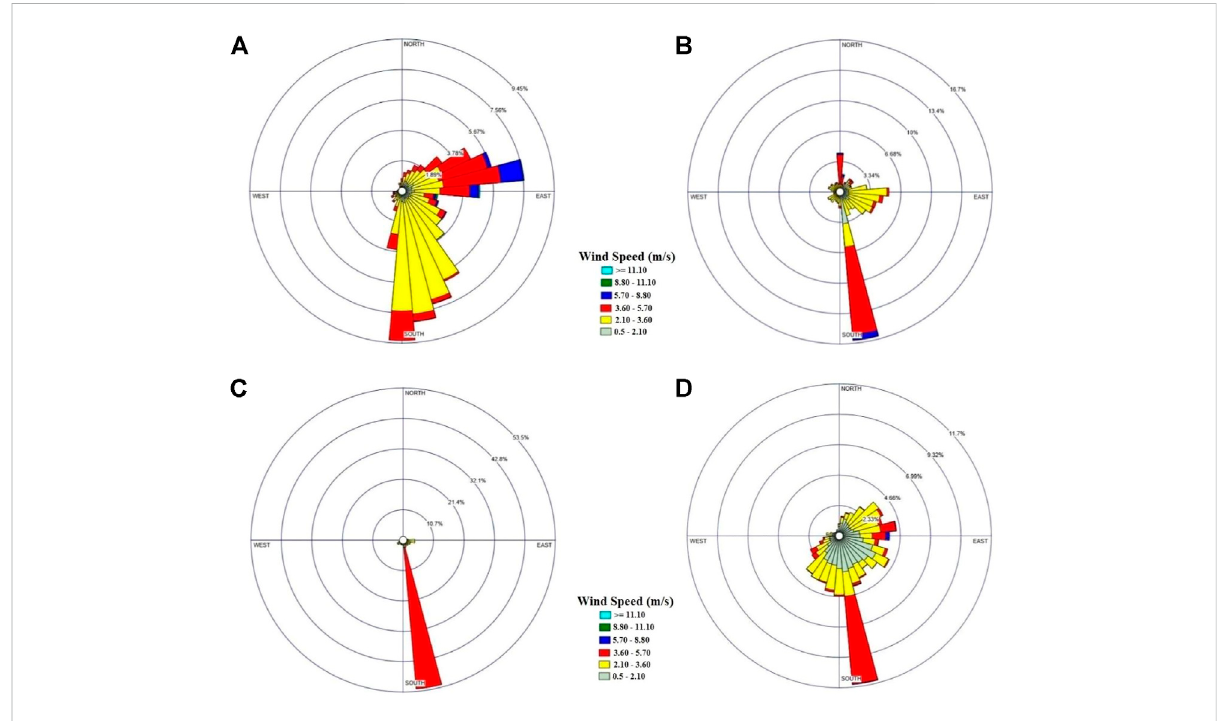
FIGURE 2 Seasonal variations of benzene, toluene, ethyl benzene, m,p-xylene, and o-xylene for (A) pre-monsoon, (B) monsoon, (C) post-monsoon, and (D) winter